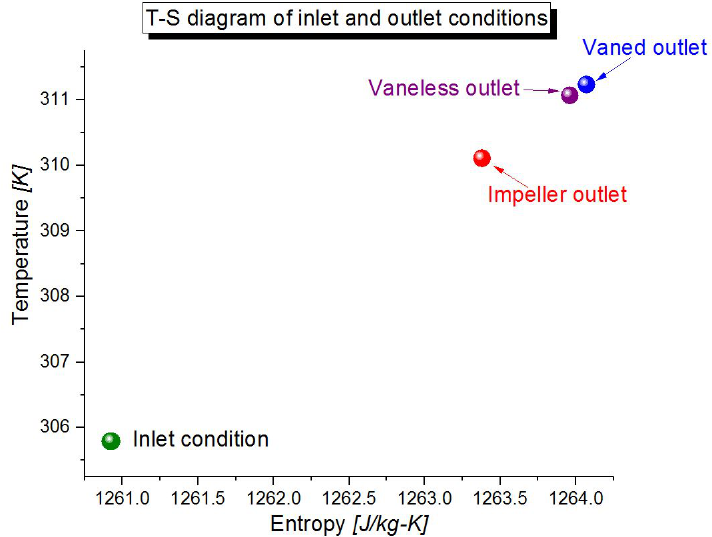
Figure 16. T-S diagram shows the inlet and outlet condition at the mass flow rate of 3.2